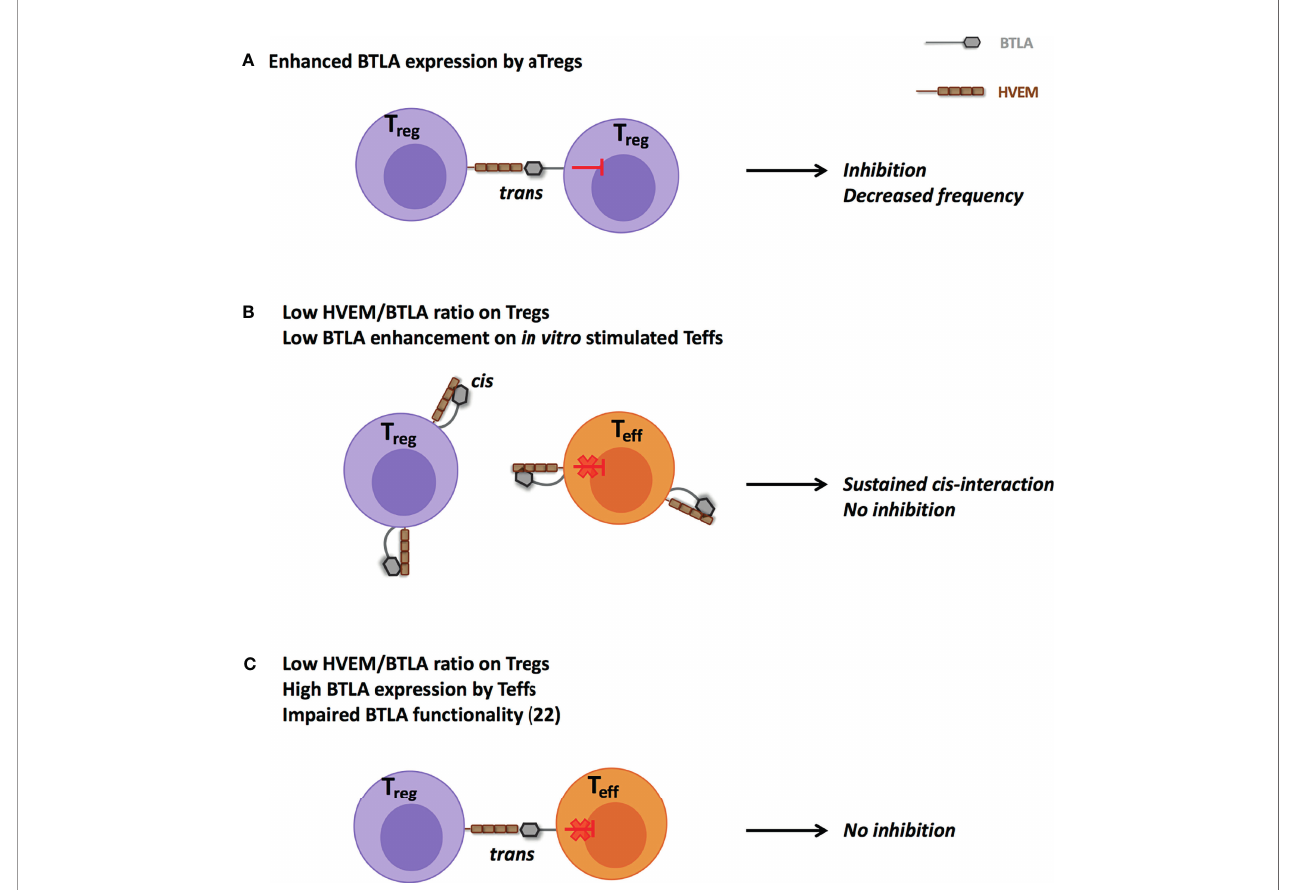
FIGURE 7 | Proposed model for impaired HVEM-mediated suppression by Tregs in lupus. (A) Enhanced ex vivo BTLA expression by lupus aTregs could favor their own inhibition and participate to their reduced frequency. (B) Increased ex vivo BTLA expression by aTregs and defective BTLA enhancement in in vitro TCR- stimulated CD4 + T cells could sustain cis -interaction and thus limit trans -interaction between lupus Tregs and effector T cells. (C) Despite higher BTLA expression, altered BTLA signaling pathway in effector CD4 + T cells (22) could prevent their effective